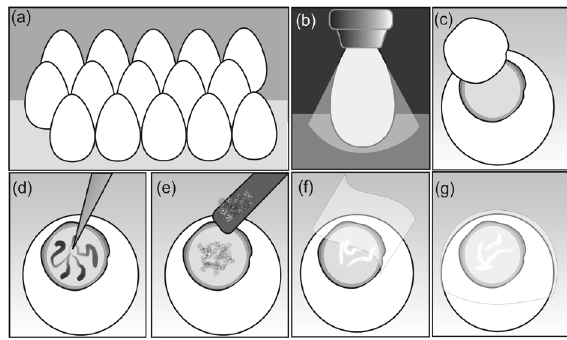
FIGURE 4 - Schema of the procedure of the HET-CAM test, in which (a) indicates receipt of eggs, their verification and storage in incubator; (b) examination of the eggs on fourth day to verify the existence and position of embryo; (c) opening of the shell eggs and wetting; (d) addition of test substance liquid; (e) addition of test substance solid; (f) closure of the opening with transparent tape; (g) assessment within of the ring for vascular damage. Figure adapted from CAMVA, 2008.